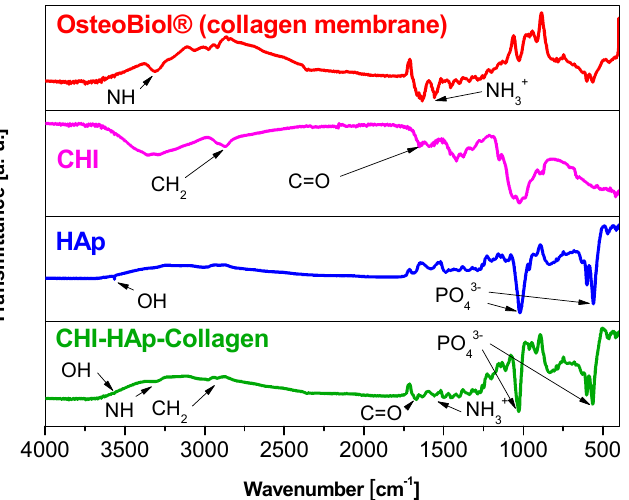
Figure 2. ATR FTIR spectra of OsteoBiol (collagen membrane), chitosan (CHI), nano-hydroxyapatite (HApNPs), and CHI–HAp–collagen.